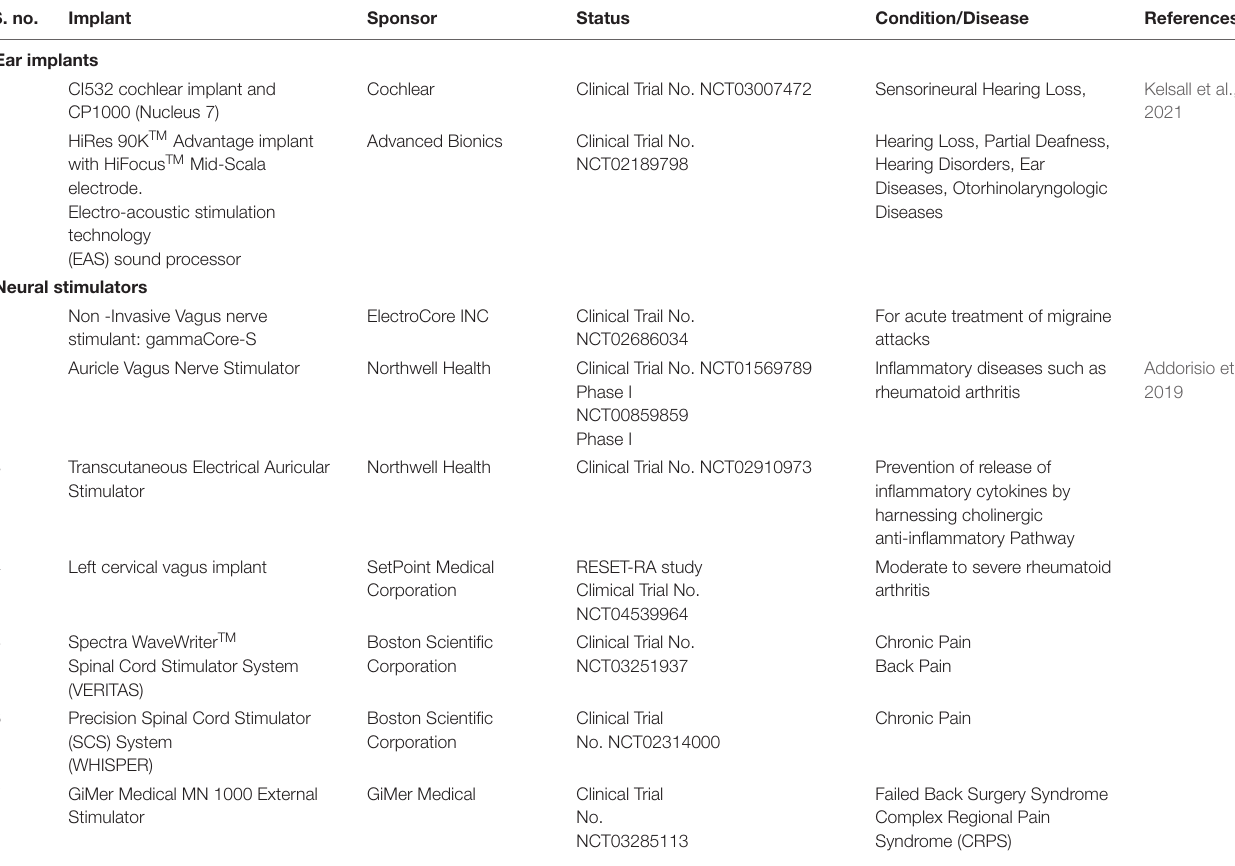
TABLE 1 | Neuromodulating devices on clinical